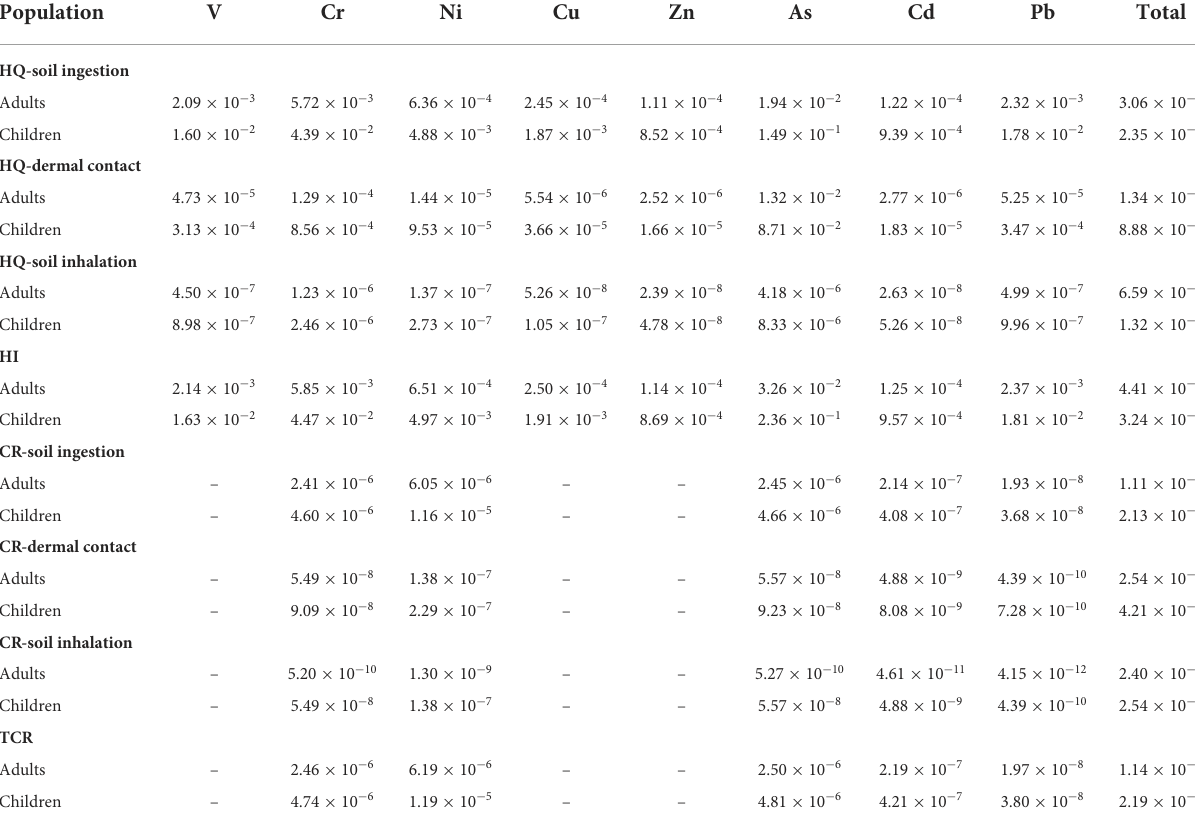
TABLE 2 Estimation of non-carcinogenic (Hazard quotient, HQ; Hazard index, HI) and carcinogenic risks (CR) posed by heavy metal in soil via Monte Carlo simulation.